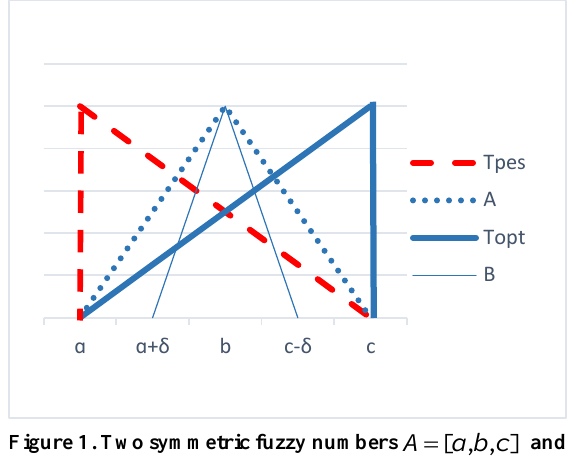
Figure 1. Two symmetric fuzzy numbers [ , , ] A a b c  and [ , , ] B a b c     and their associated fuzzy targets T are, respectively, depicted by dashed and T and opt pes solid